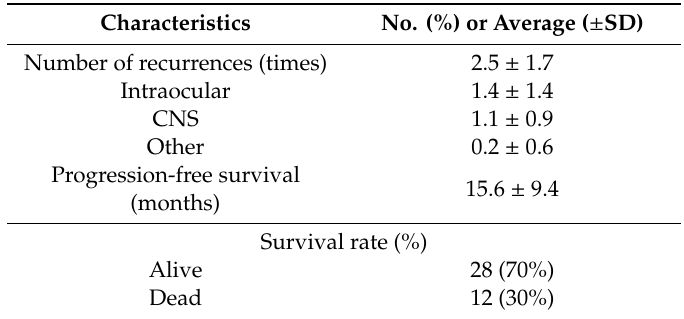
Table 3. Clinical course: recurrences and others in follow-up period.